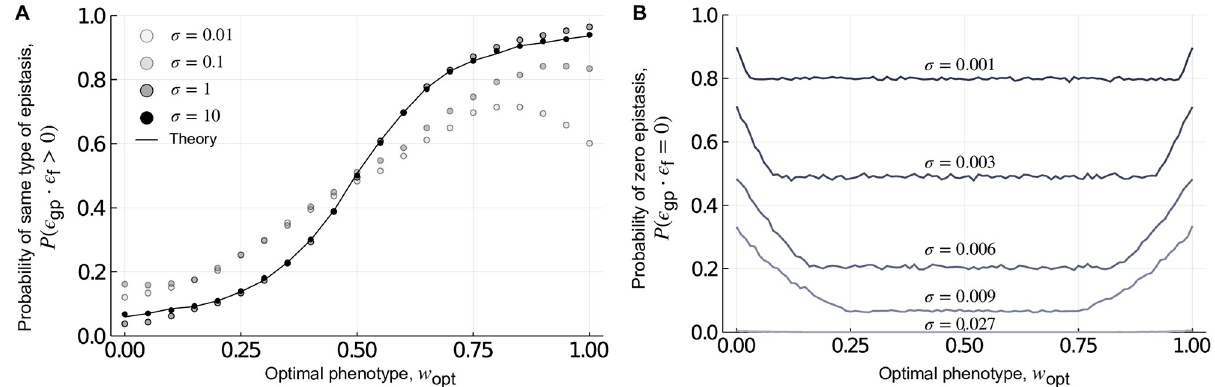
Fig 2. Local incongruence: Magnitude epistasis. (A) The probability of retaining the type of epistasis, shown in relation to the optimal phenotype w opt . The black line shows the theoretical prediction and the dots show the results from randomly generated genotype-phenotype landscapes for different values of σ . The theoretical approximation agrees well with the results from randomly generated genotype-phenotype landscapes for large σ (i.e., σ � 1). (B) The probability of observing zero magnitude epistasis in the fitness landscape, shown in relation to w opt , for different values of σ , which we selected to show the range of variation in the probability of observing zero